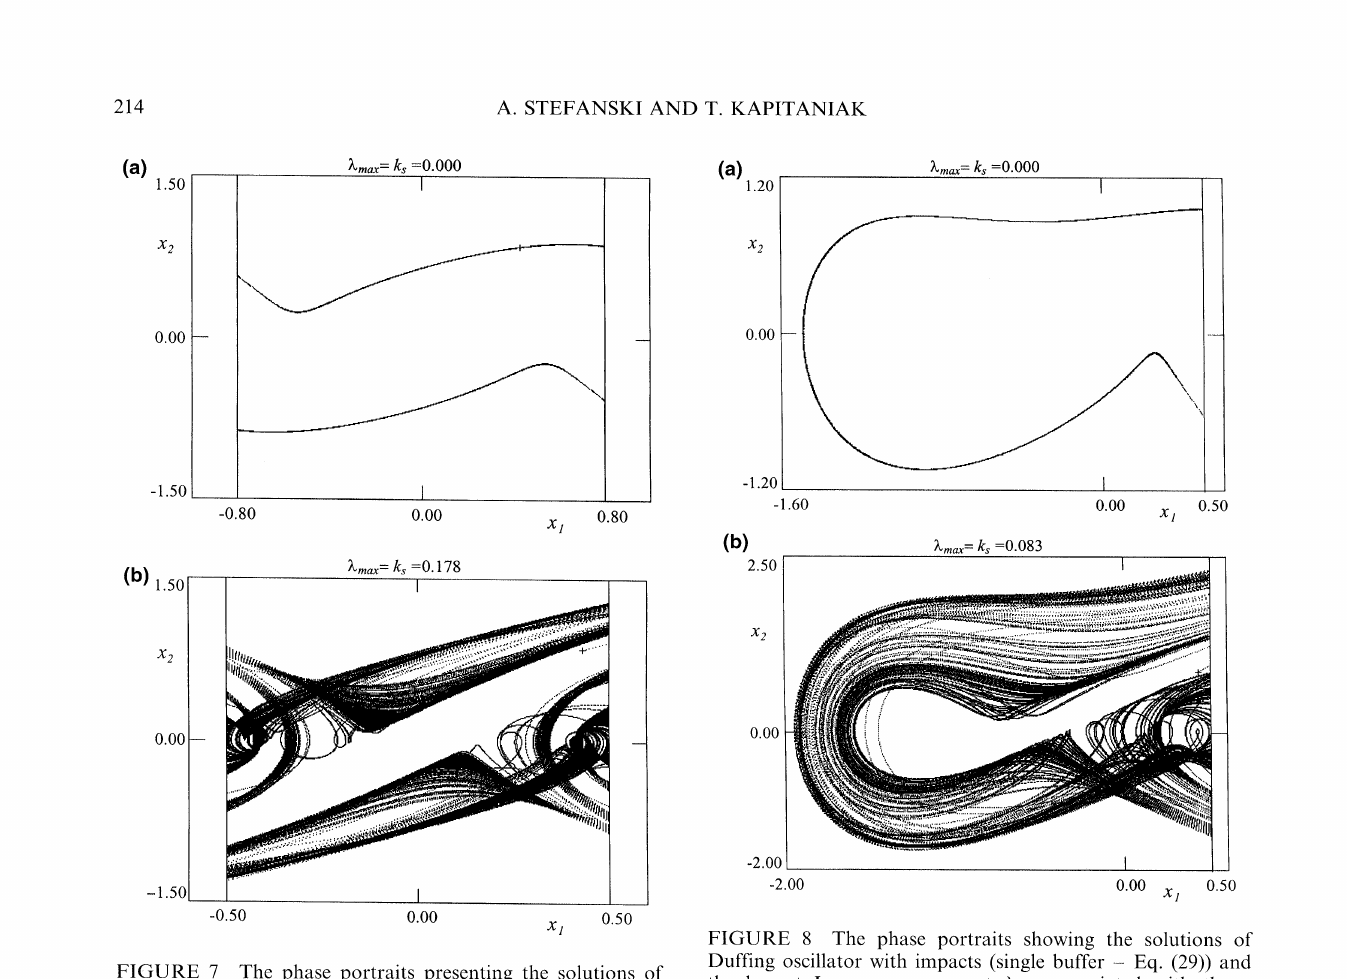
FIGURE 7 The phase portraits presenting the solutions of Duffing oscillator with impacts (two buffers Eq. (28)) and the largest Lyapunov exponent Ama associated with them: (a) periodic solution